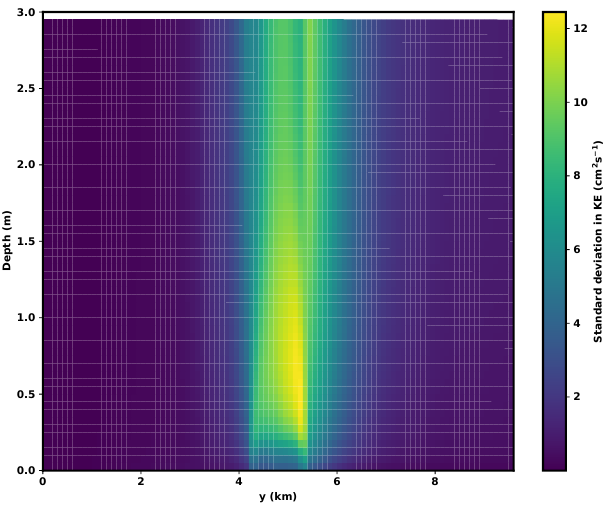
Figure 5. Standard deviation in kinetic energy (cm 2 s − 1 ) in the presence of vegetation (cross-sectional